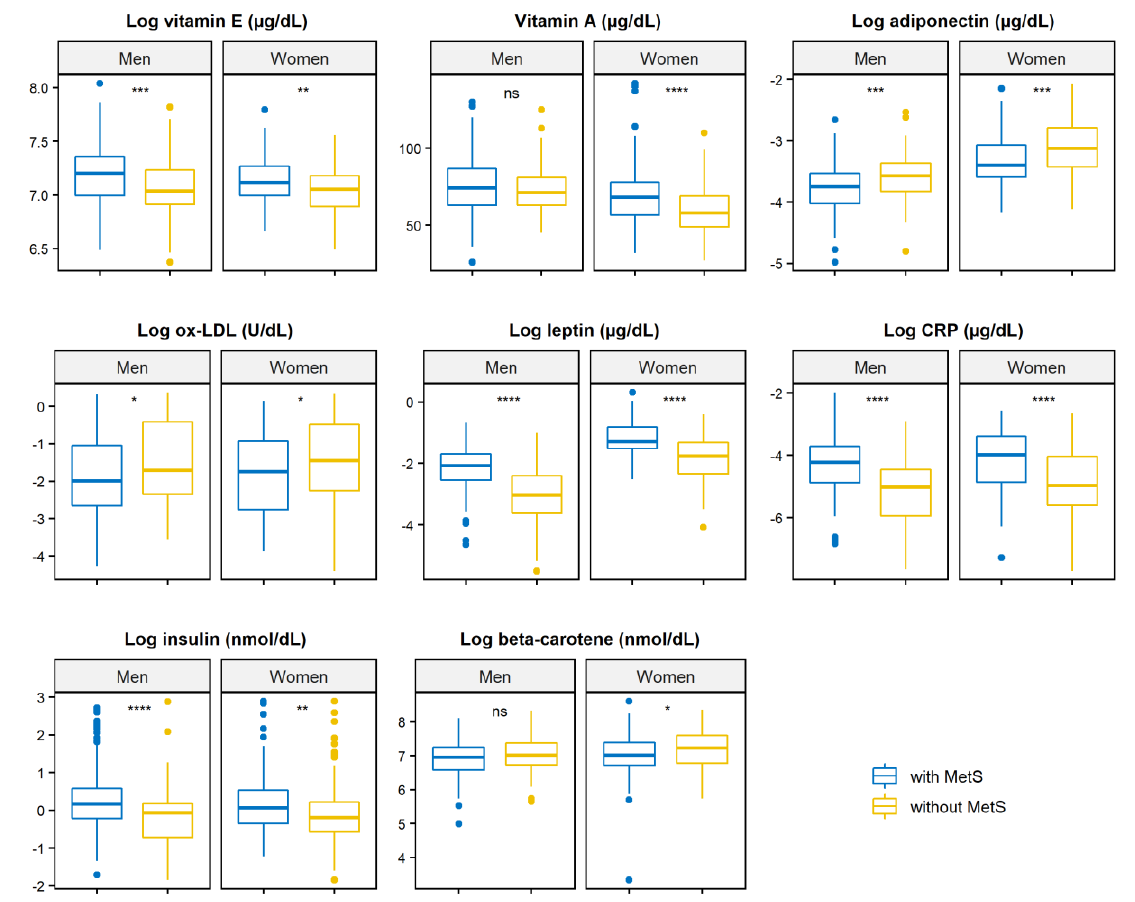
Figure 2. Concentrations of markers of dietary nutrient intake, inflammation, and oxidative stress by metabolic syndrome, stratified by sex. All concentrations were natural log-transformed with the exception of vitamin A. Original units prior to log-transformation were vitamin E ( µ g/dL), adiponectin ( µ g/dL), ox-LDL (U/dL), leptin ( µ g/dL), CRP ( µ g/dL), insulin (nmol/dL), and beta-carotene (nmol/dL). Ns: p -value > 0.05; * p -value ≤ 0.05; ** p -value ≤ 0.01; *** p -value ≤ 0.001; **** p -value ≤ 0.0001. Ox-LDL: oxidized low-density lipoprotein; CRP: c-reactive protein.